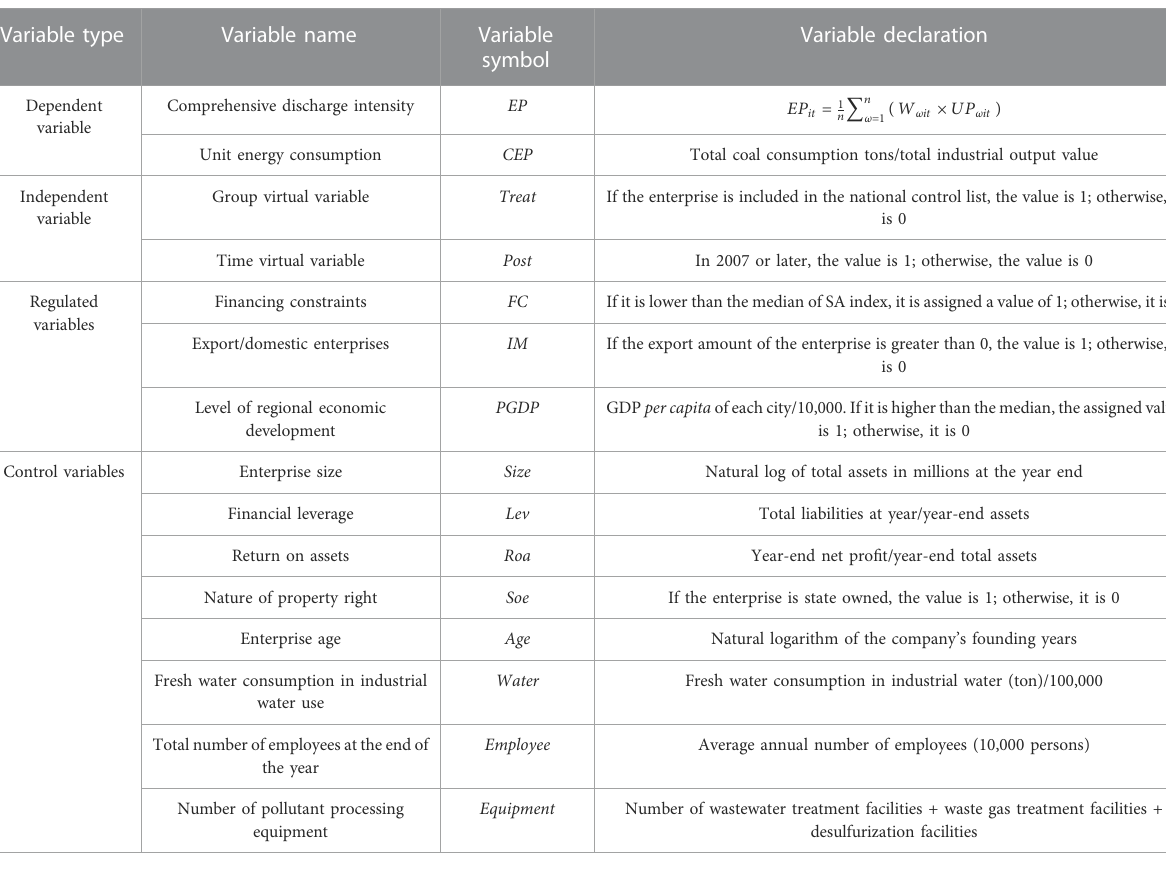
TABLE 1 De fi nition of primary